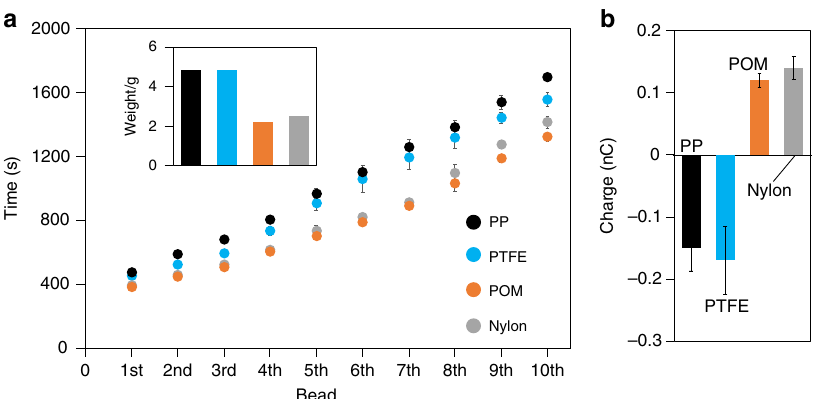
Fig. 3 Universality of light-induced discharging for common polymers. a Polymer beads made up from different polymers, poly(tetra fl uoroethylene) (PTFE), nylon, poly(oxymethylene) (POM), polypropylene (PP) all discharge in Coumarin 6 (C6) solutions upon illumination with 366 nm UV light (Bead diameter = 1.6 mm, 1 min charging time in 5 × 10 − 4 M C6 ). The differences in the discharge times emerge from the different weights (a, inset) and b initial charges of the polymer beads. Source data are provided as a Source Data